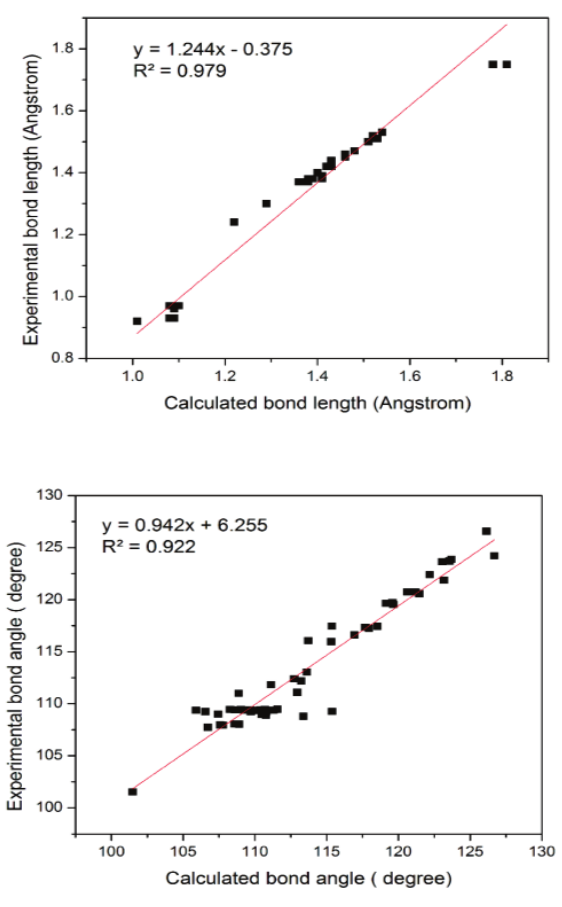
Figure 2: Linear curve fitting plots of the calculated and experimental bond lengths and bond angles parameters for the title compound. Table 1: The calculated optimized geometrical parameters of compound at B3LYP/6- 311++G(d,p) level of basis set.